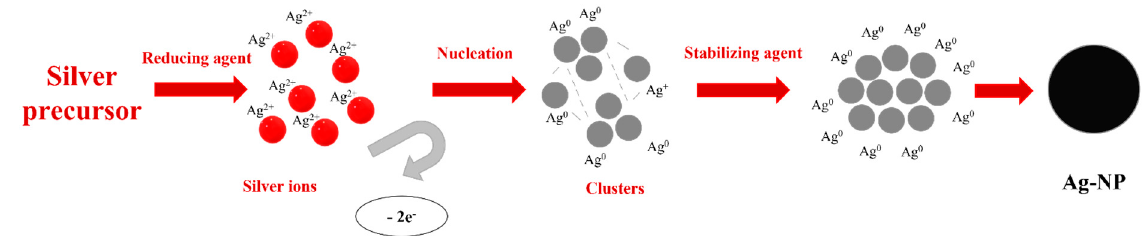
Figure 3. Mechanism of chemical reduction of a silver precursor in Ag-NP formation.